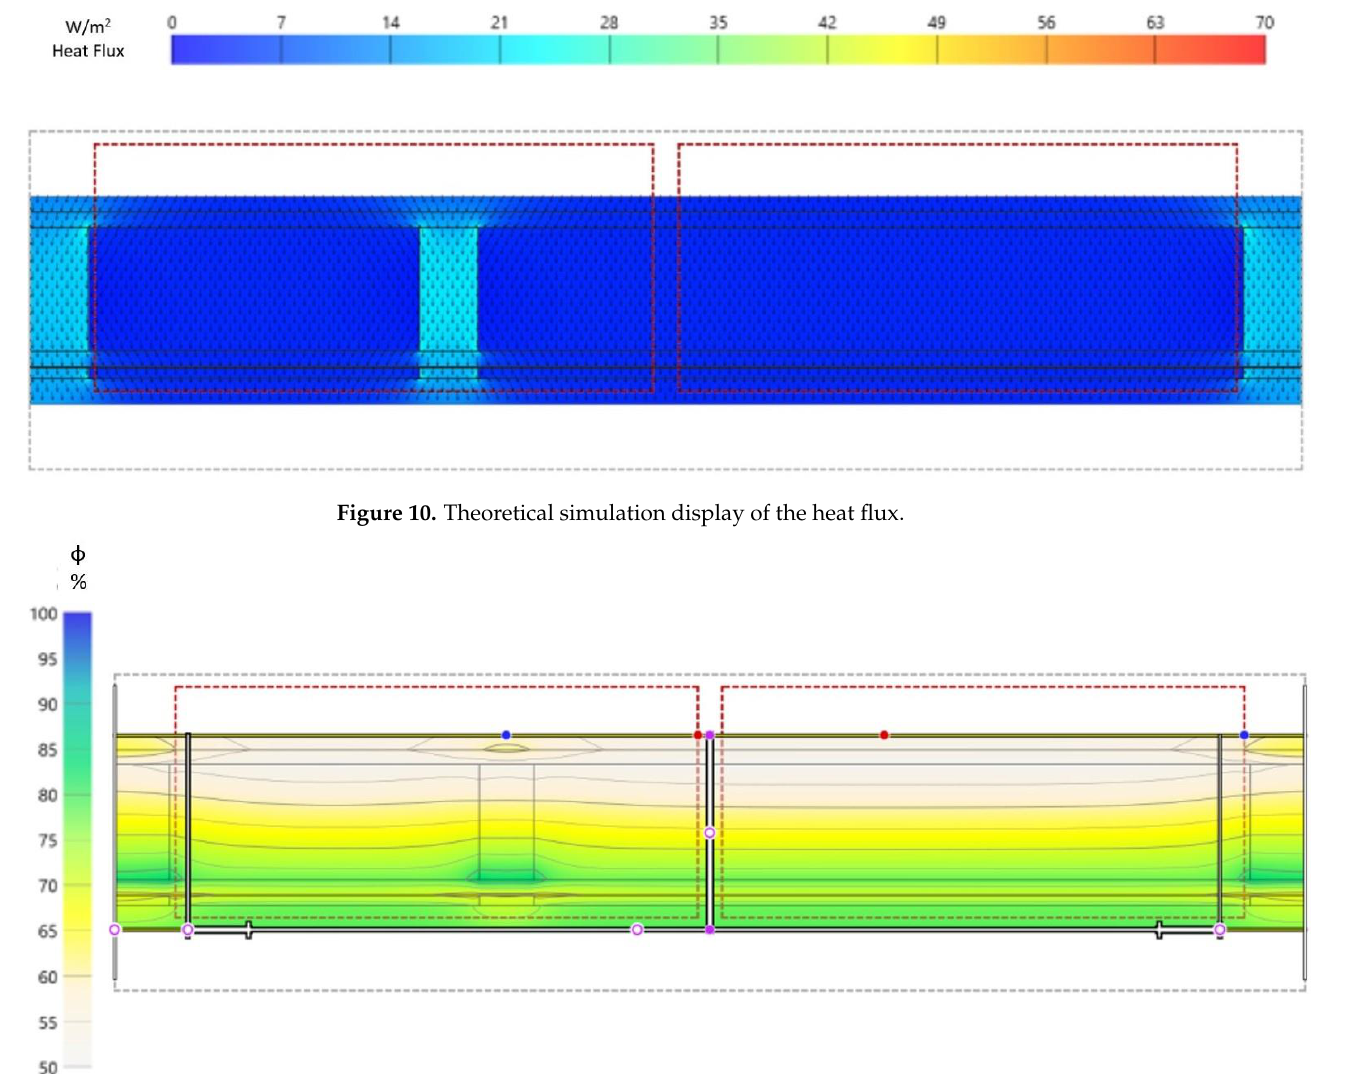
Figure 11. Theoretical simulation display of the